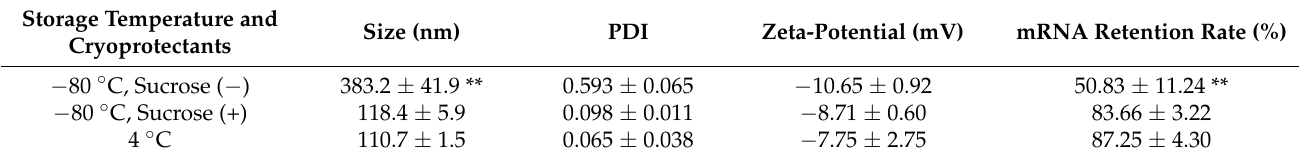
Table 3. Effects of the cryoprotectants on particle properties of the mRNA encapsulating LNPs.